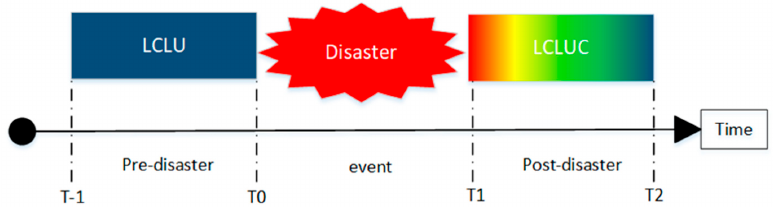
Figure 3. The relationship between the post-disaster recovery process and land cover and land use (LCLU). (LCLU).